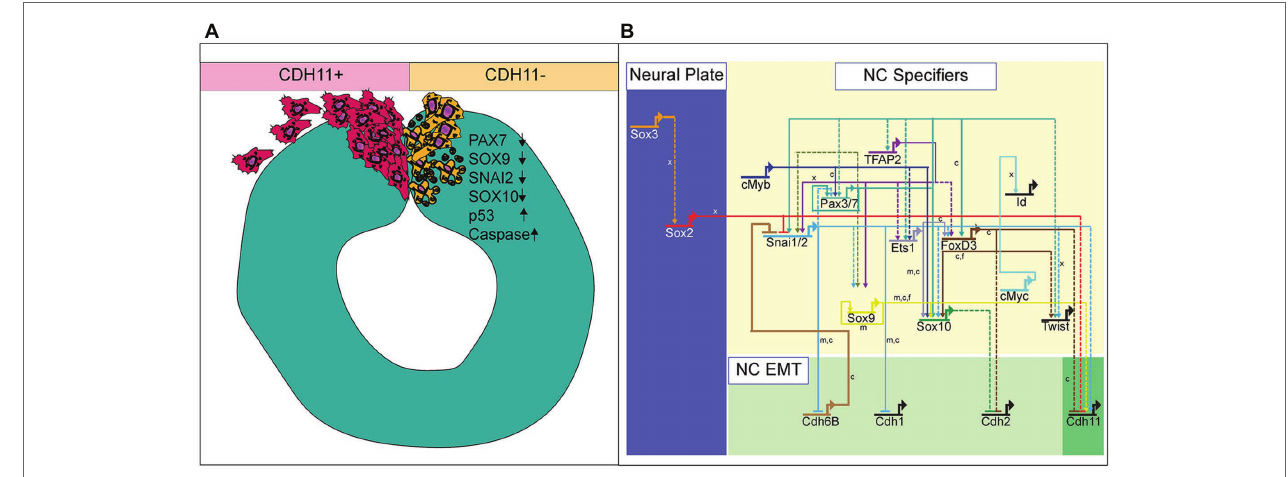
FIGURE 7 | Summary diagram of CDH11-knockdown phenotype. (A) Image depicting NC cell development in normal NC cells (CDH11+) and cells lacking CDH11 (CDH11-). Normal cells undergo EMT, exit the neural tube, migrate collectively, and then progressively mesenchymalize as development proceeds. Normal lamellipodial and filopodial projections form as the cells navigate through the extracellular matrix. In the absence of CDH11, NC cells are induced, but undergo p53- mediated apoptosis due to either (1) inability to complete EMT/migration or (2) altered intracellular signaling in the absence of CDH11. PAX7, SOX9, SNAI2, and SOX10 positive cells are all significantly reduced in the absence of CDH11 while p53 and *Casp3 are upregulated. (B) Simplified NC GRN identifying NC specifiers and multiple putative inputs into the CDH11 upstream regulatory region as identified by ATAC-seq performed on NC cells (Williams et al., 2019). Little is known about the downstream targets and effectors of most cadherin proteins in the NC GRN with the exception of CDH6B (Schiffmacher et al., 2016) and CDH11 in migratory NC cells (Kashef et al., 2009; Koehler et al., 2013), and therefore identifying their targets in premigratory NC cells is essential. Direct binding relationships are indicated with solid lines while putative regulatory relationships are indicated by dashed lines. Letters indicate species in which experiments were performed: x = Xenopus , c = chicken, m = mouse. GRN information sourced from Rogers and Nie